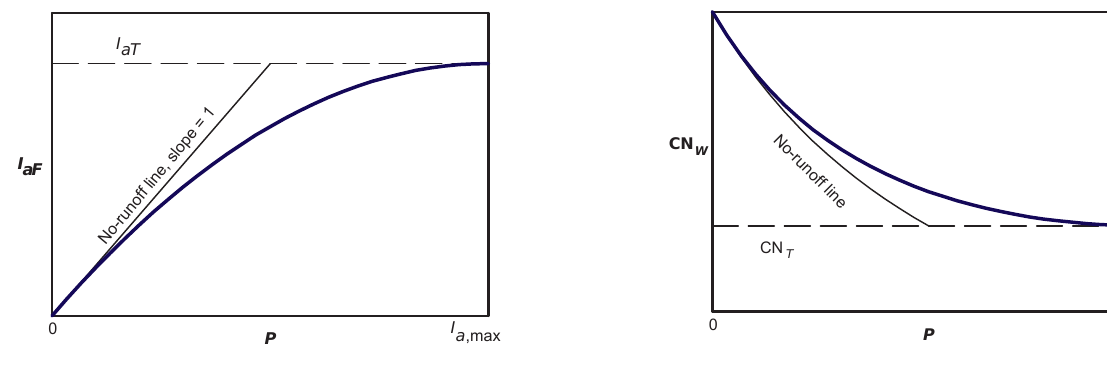
Figure 7. CN W as a function of P when I aW is assumed to be equal to I aF (shown in Fig.